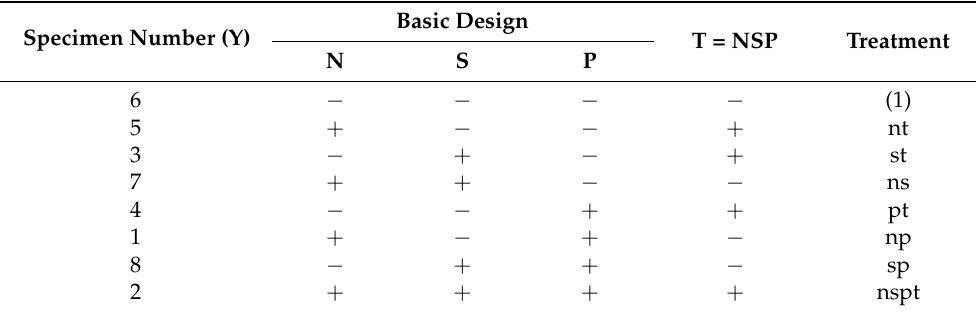
Table 2. The 2 4 − 1 fractional factorial design, principal one-half fraction, applied to the screening IV experiment of degassing